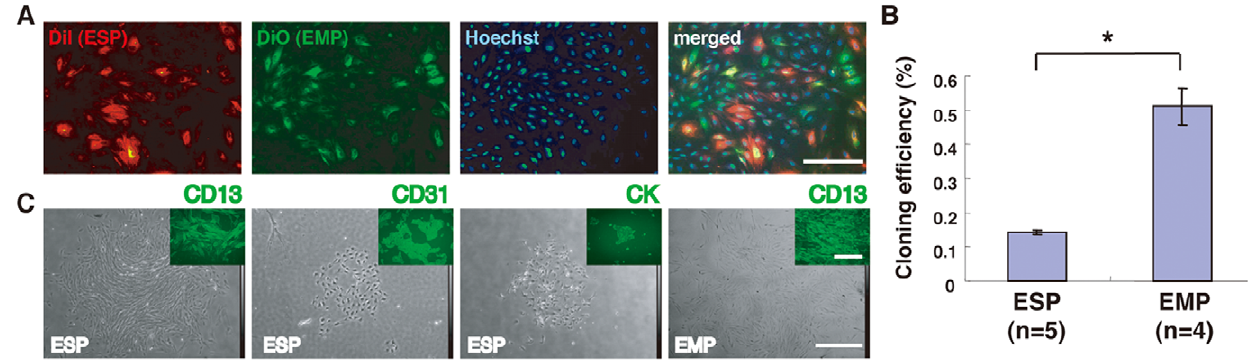
Figure 3. Growth and differentiation potentials of ESP and EMP cells. ( A ) Fluorescence images of DiI-labeled ESP cells co-cultured with DiO- labeled EMP cells following Hoechst DNA dye staining. Bars, 200 m m. ( B ) Cloning efficiencies of ESP cells and EMP cells in EGM-2MV medium. * P , 0.001. Each bar indicates the mean 6 SEM. N $ 4. ( C ) Phase contrast micrographs and fluorescence images (insets) of colonies generated from ESP and EMP cultures. The ESP cells and EMP cells were separately seeded at a clonal density, cultured in EGM-2MV medium for two weeks, and subjected to immunofluorescence studies using antibodies against the indicated markers. CK, cytokeratin. Bars, 500 m m.